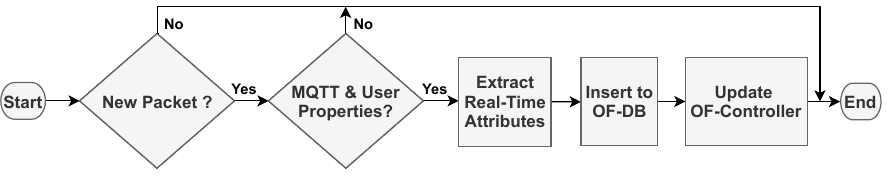
Figure 3. RT-NM operation flow